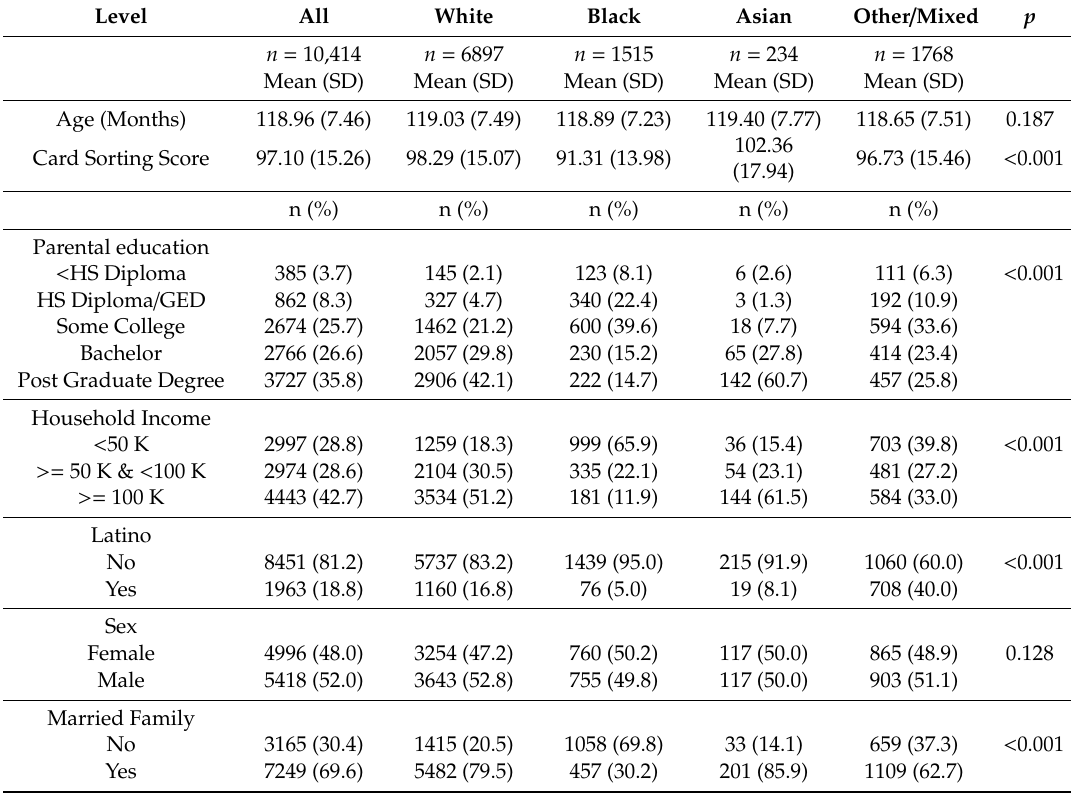
Table 1. Presents the descriptive statistics of the pooled sample and by race.